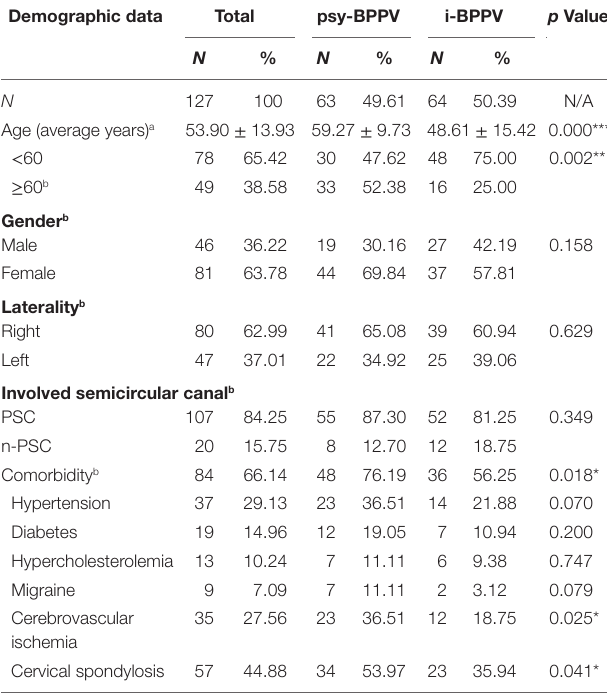
TaBle 1 | Demographic information on BPPV patients.